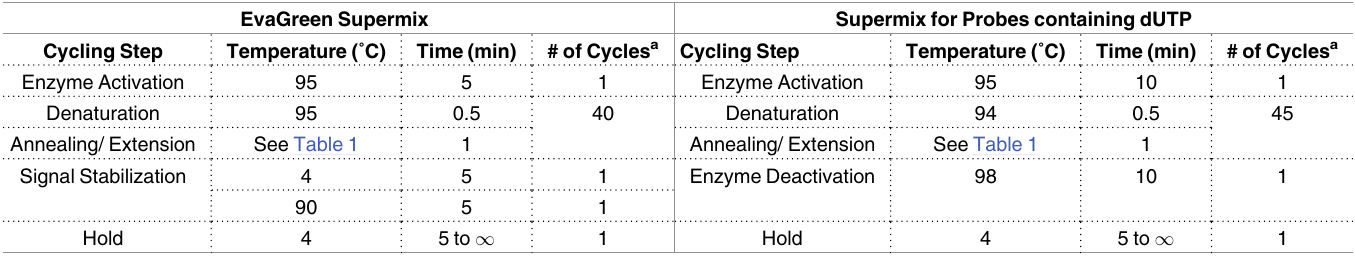
Table 4. Droplet digital cycling